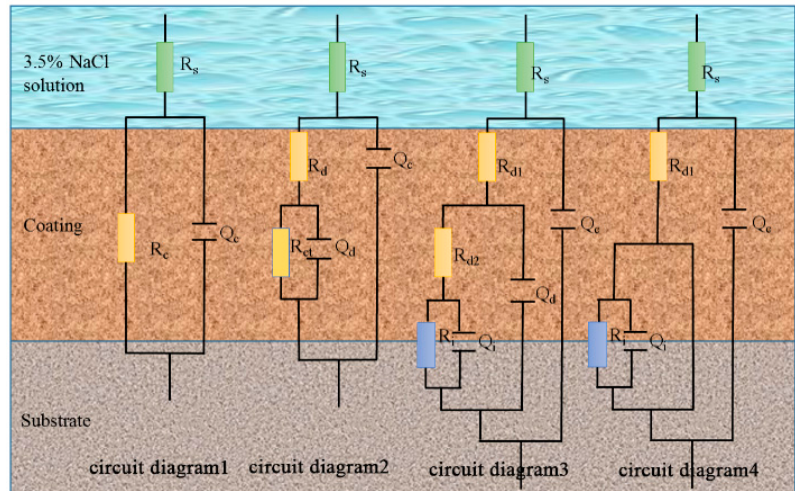
Figure 3. The corresponding equivalent circuit.